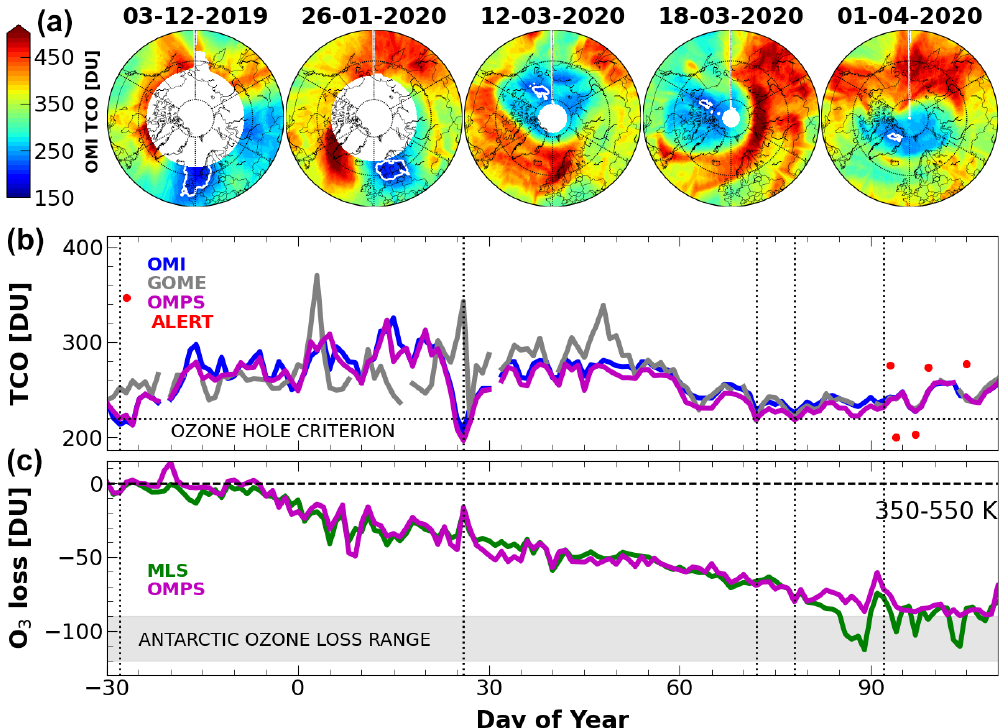
Figure 7. Arctic ozone in the total column and partial column ozone. (a) The maps of total column ozone from the OMI satellite mea- surements in the Arctic for selected ozone hole days for the winter of 2020. (b) The lowest (5%) TCO measured inside the vortex from three different satellite measurements (OMI, GOME, and OMPS). The difference in total column measurements is due to the difference in coverage of the measurements in the Arctic region. The ozone hole criterion of 220DU is indicated by the dotted line. The total column ozone (TCO) measurements at Alert station are also shown (red solid circles). (c) The partial column ozone loss computed at the altitude range 350–550K from the MLS and OMPS measurements. The ozone loss estimated in the Antarctic winters at the same altitude range is shown as the grey-coloured